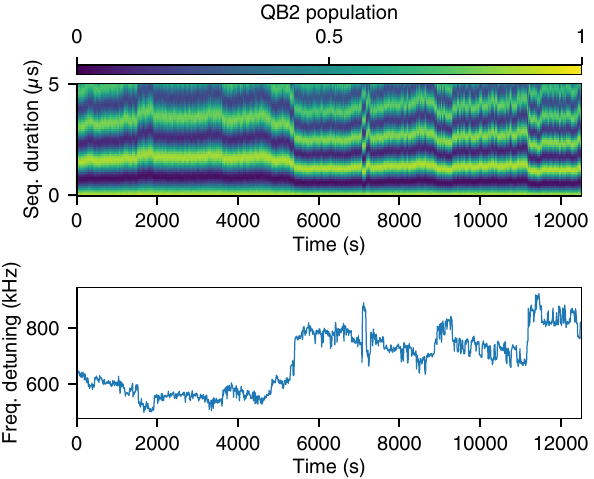
FIG. 11. Fluctuation in the QB2 frequency as a function of time, measured via repeated Ramsey experiments. We compute the PSD of the frequency fluctuation by using the scipy.signal.welch function from the open-source PYTHON library SciPy.